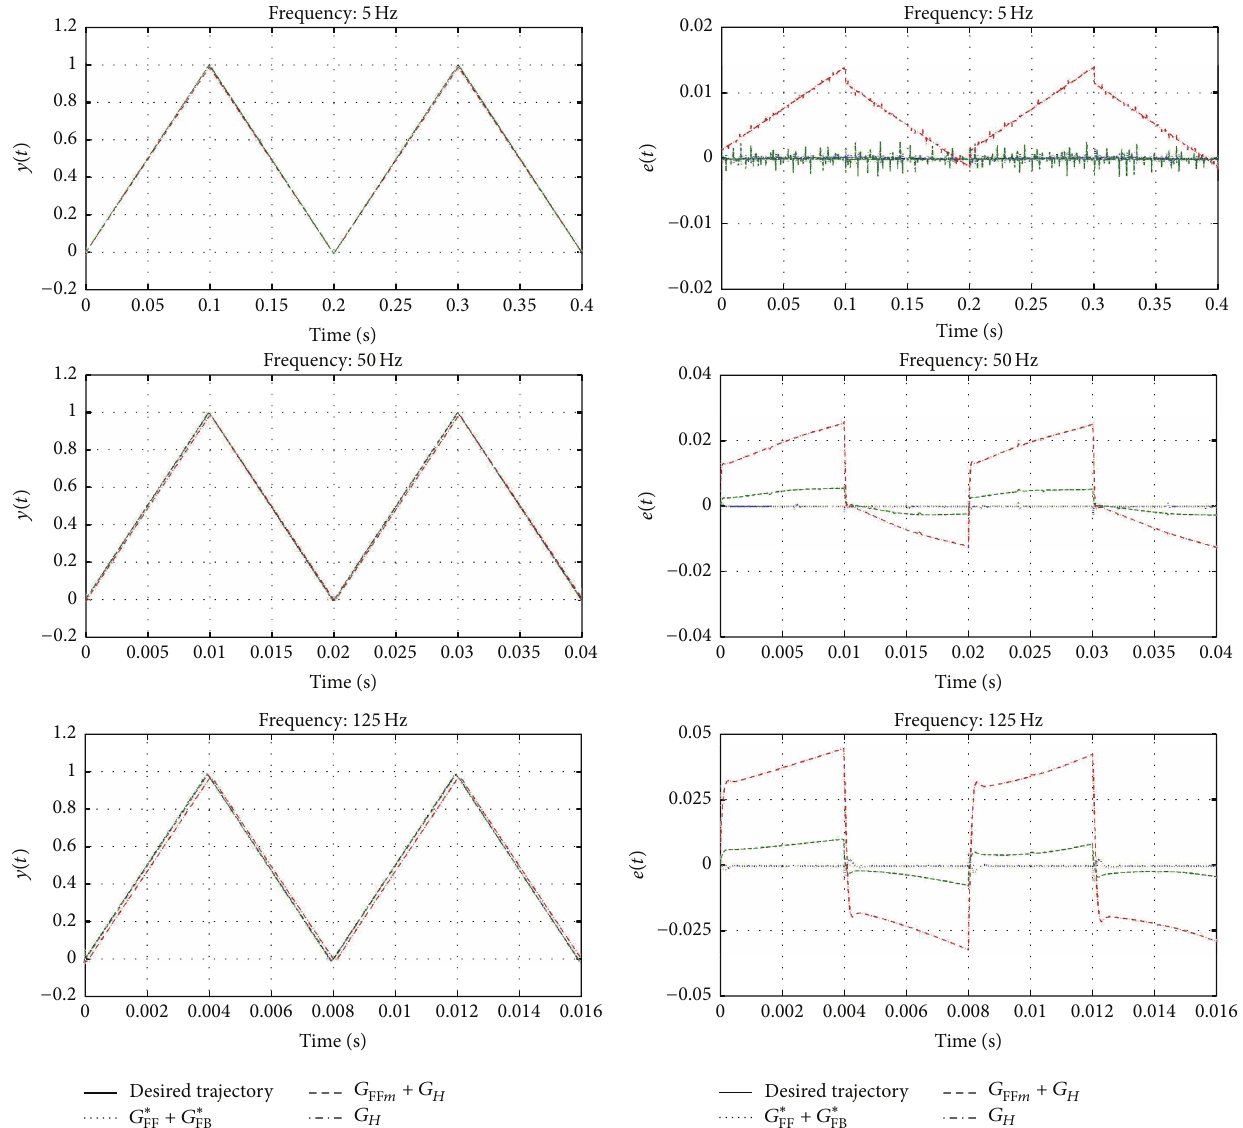
Figure 7: AFM 𝑥 -axis positioning control simulation experiment